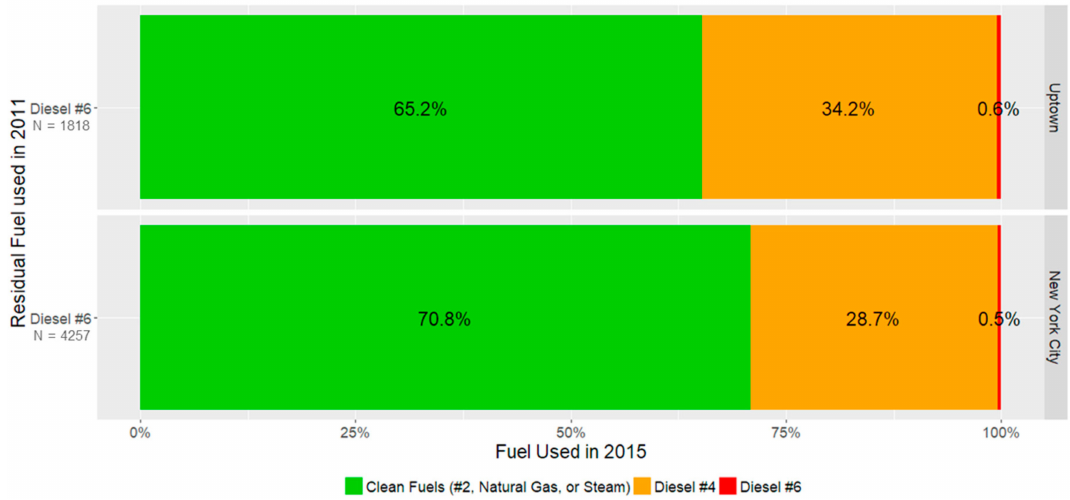
Figure 3. Of buildings burning diesel #6 in 2011, what fuel were they using by